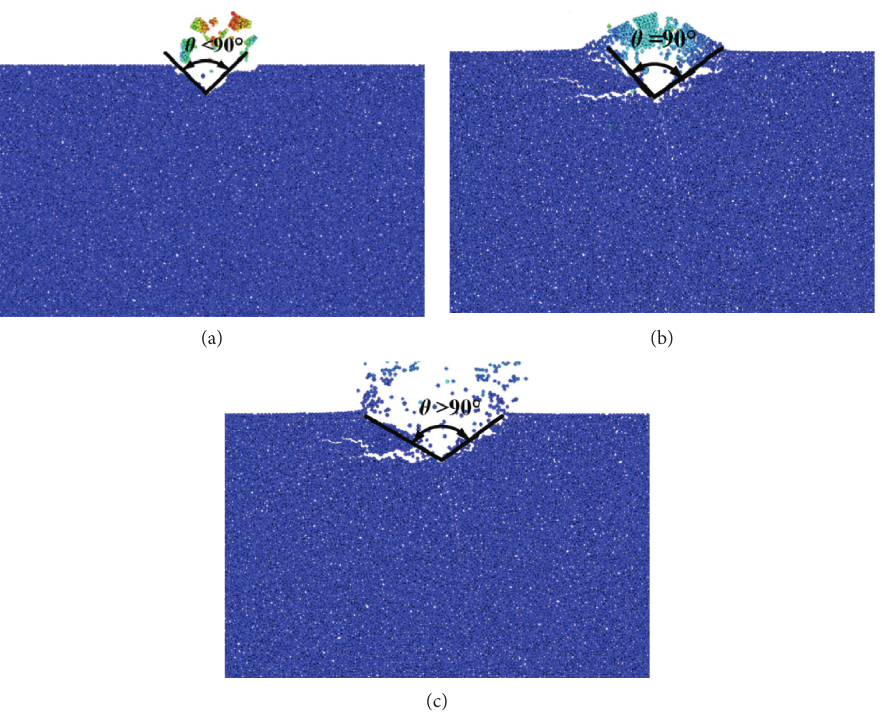
Figure 5: Numerical simulation of three kinds of throwing blasting: (a) weakened throwing blasting, (b) normal throwing blasting, and (c) enhanced throwing blasting.